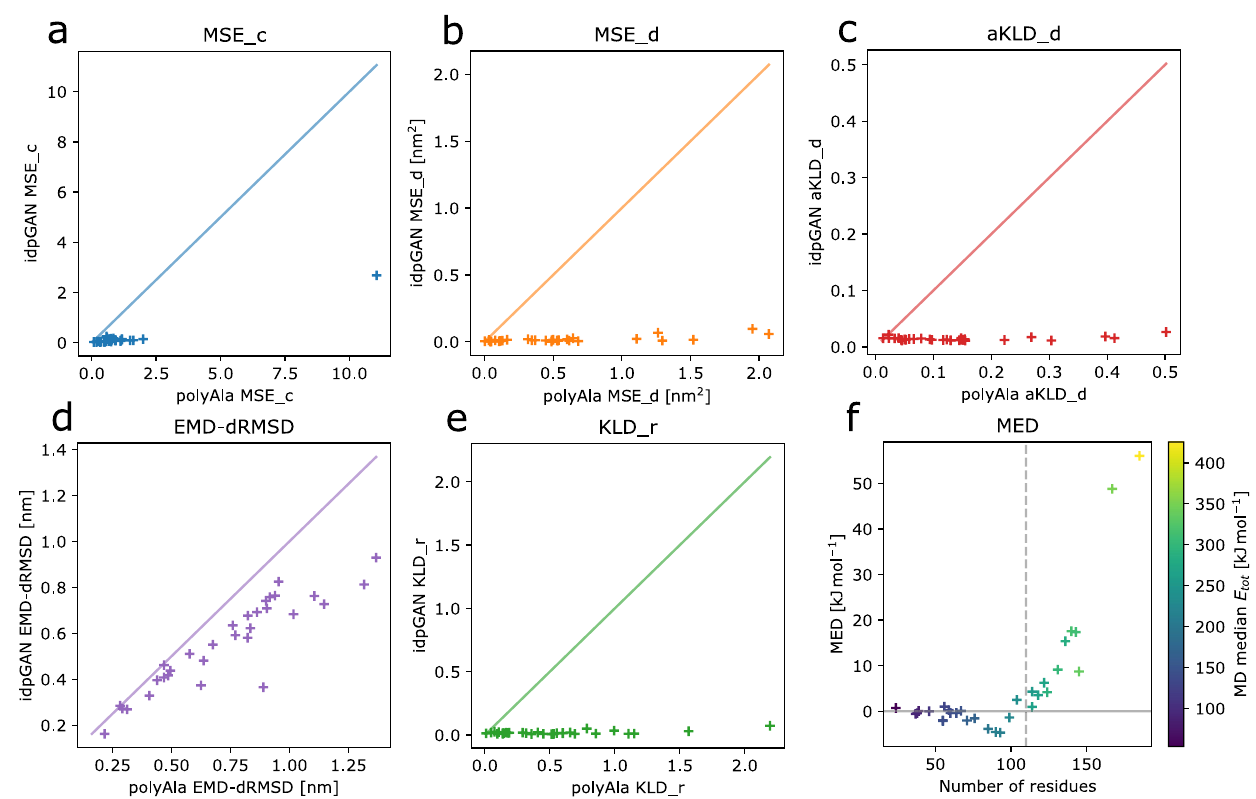
Fig. 4 | Evaluation of idpGAN and polyAla ensembles for approximating MD data. ResultsarereportedforIDP_testsetproteins( n =31). a , b , c , d ,and e showthe valuesofMSE_c,MSE_d,aKLD_d,EMD-dRMSDandKLD_r,respectively,obtainedby polyAla(x-axis)andidpGAN(y-axis)foralltheproteinsintheset.See “ Methods ” for a description of the metrics. Lower values indicate better performance in Table 1 | Evaluation of idpGAN for the IDP_test set